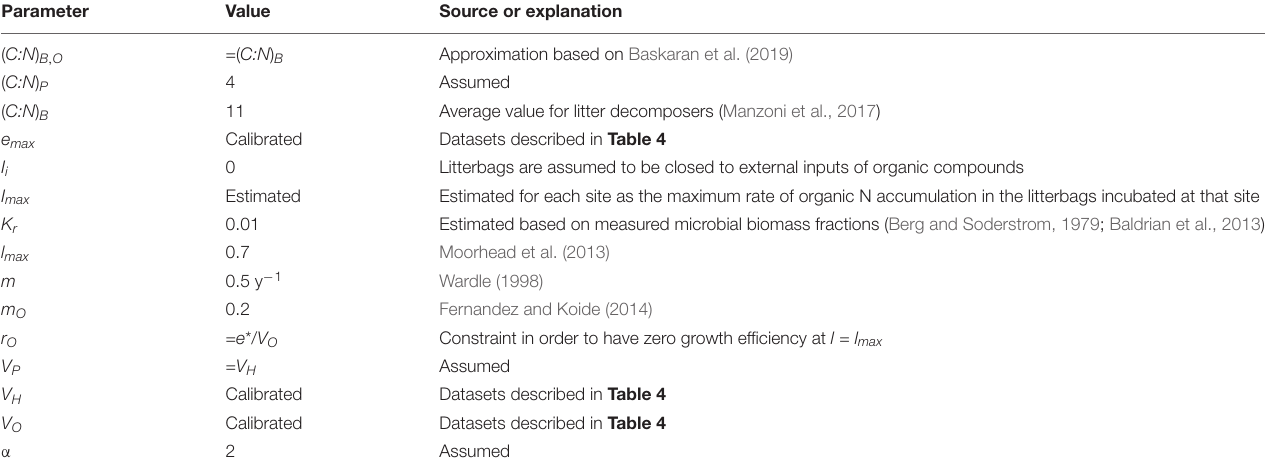
TABLE 3 | Values of model parameters and their sources.